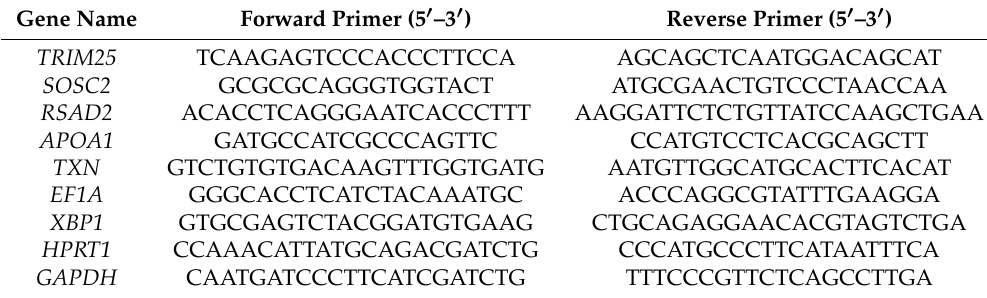
Table 1. Primer sequences used for